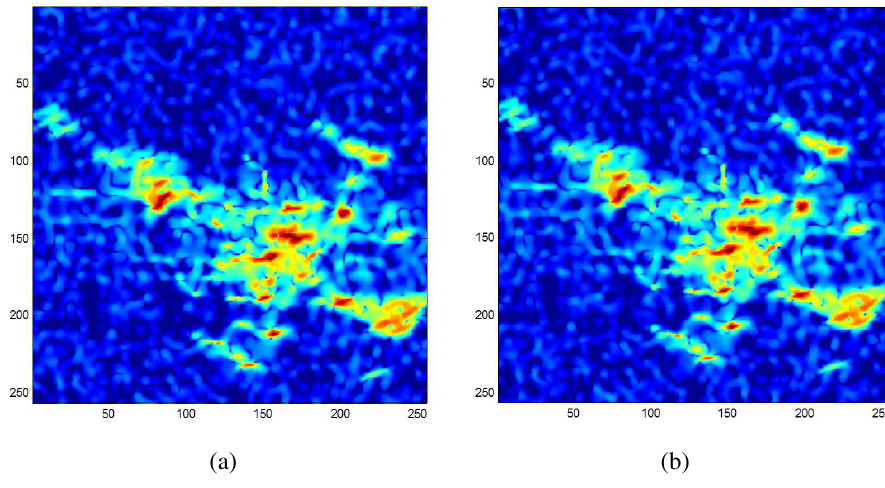
Figure 11. Comparison between full-band ( a ) and sub-band ( b ) APES images: the imaging for (a) costs 26.85 h, while for (b), it is 0.84